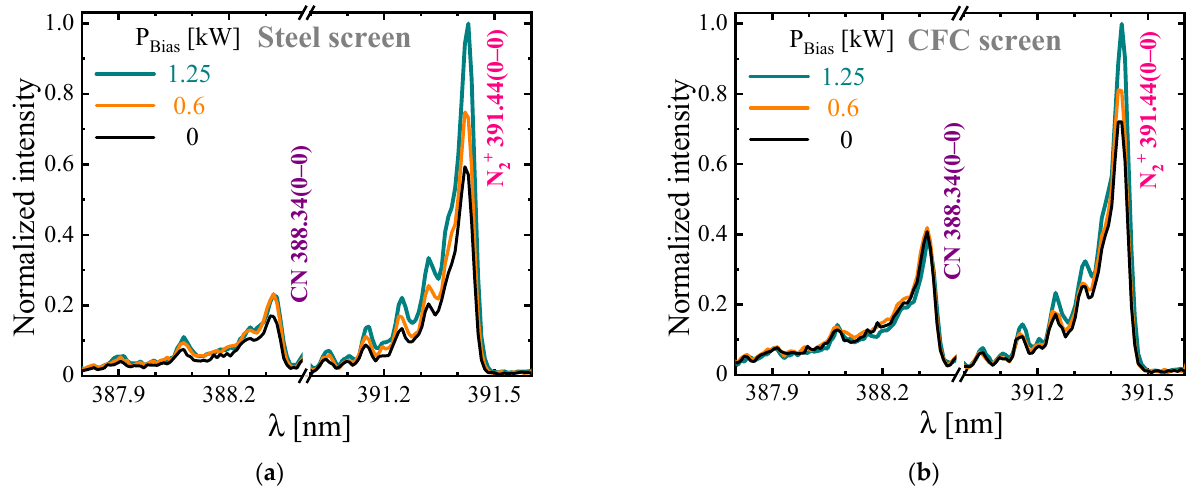
Figure 6. CN and N 2+ emission bands as functions of the bias power, measured with high-resolution OES during ASPNC treatment using a steel AS ( Φ CH4 = 4 slh) ( a ) and a CFC-AS ( b ) at H 2 :N 2 = 1:1, p = 3 mbar, T = 460 °C, and Φ Total = 80 slh. The intensities are normalized to the N 2+ peak intensity at P Bias = 1.25 kW.